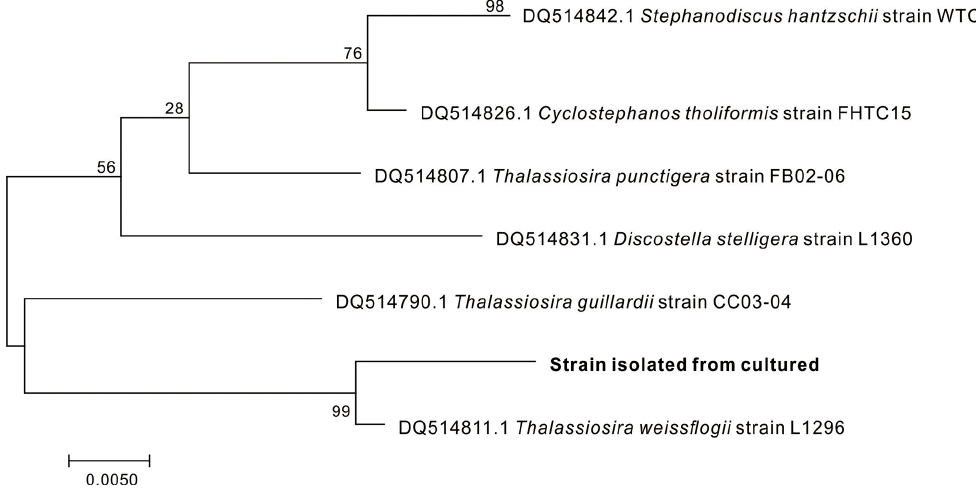
Figure 1. Phylogenetic trees of diatom strains isolated from the culturing diatoms. The scale bar indicates the number of substitutions per site for a unit branch